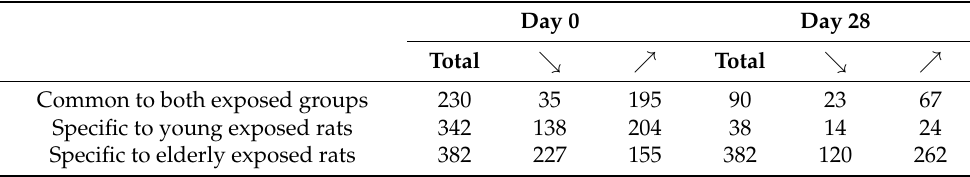
Table 3. Number of DEGs on day 0 and day 28 after exposure in both